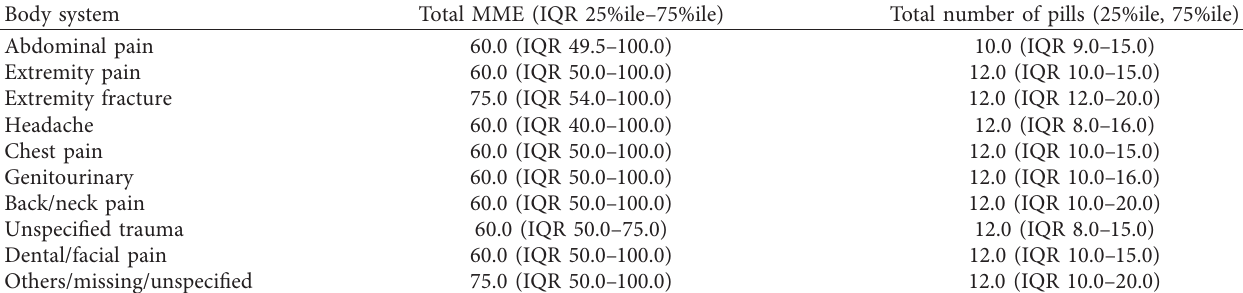
Table 2: Total prescribed MME and the number of pills by the body system.